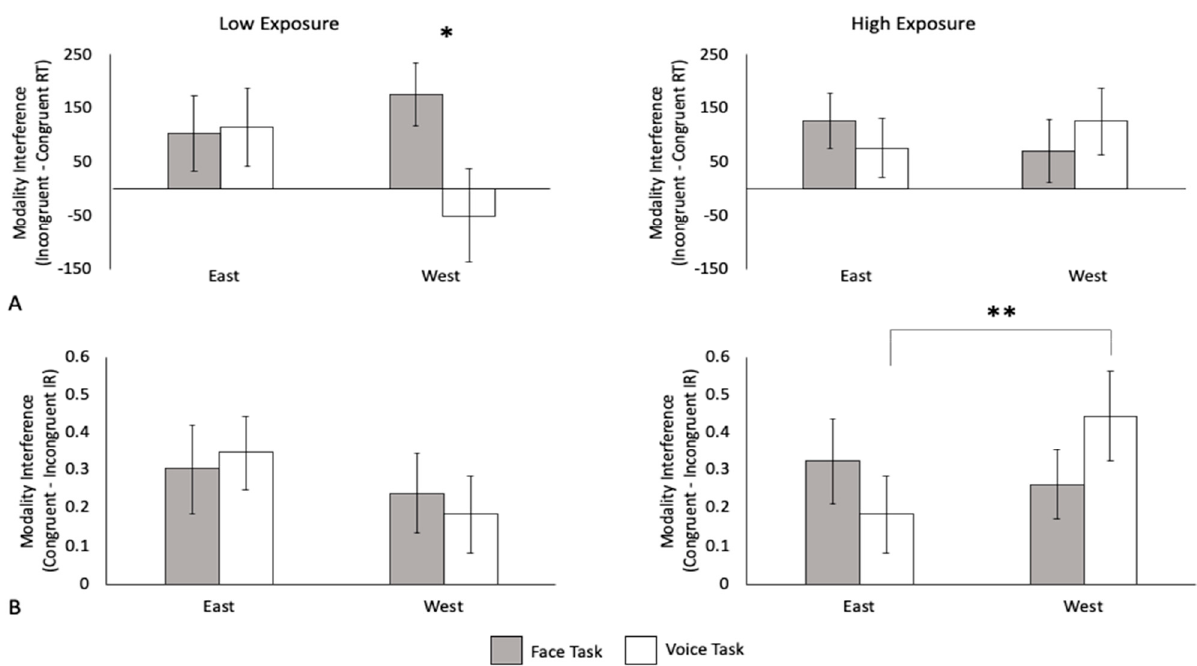
Figure 4. Modality interference effects on ( A ) response times and ( B ) intensity ratings for bilinguals with low (left panels) and high (right panels) levels of exposure to the U.S. culture. The low exposure group showed a larger modality interference in the face task than in the voice task for emotional information from the West (i.e., auditory interference). The high exposure group showed a larger modality interference for Western than Eastern emotional information in the voice task, but no differences in modality interference between cultures in the face task. * p < 0.05, ** p < 0.01.